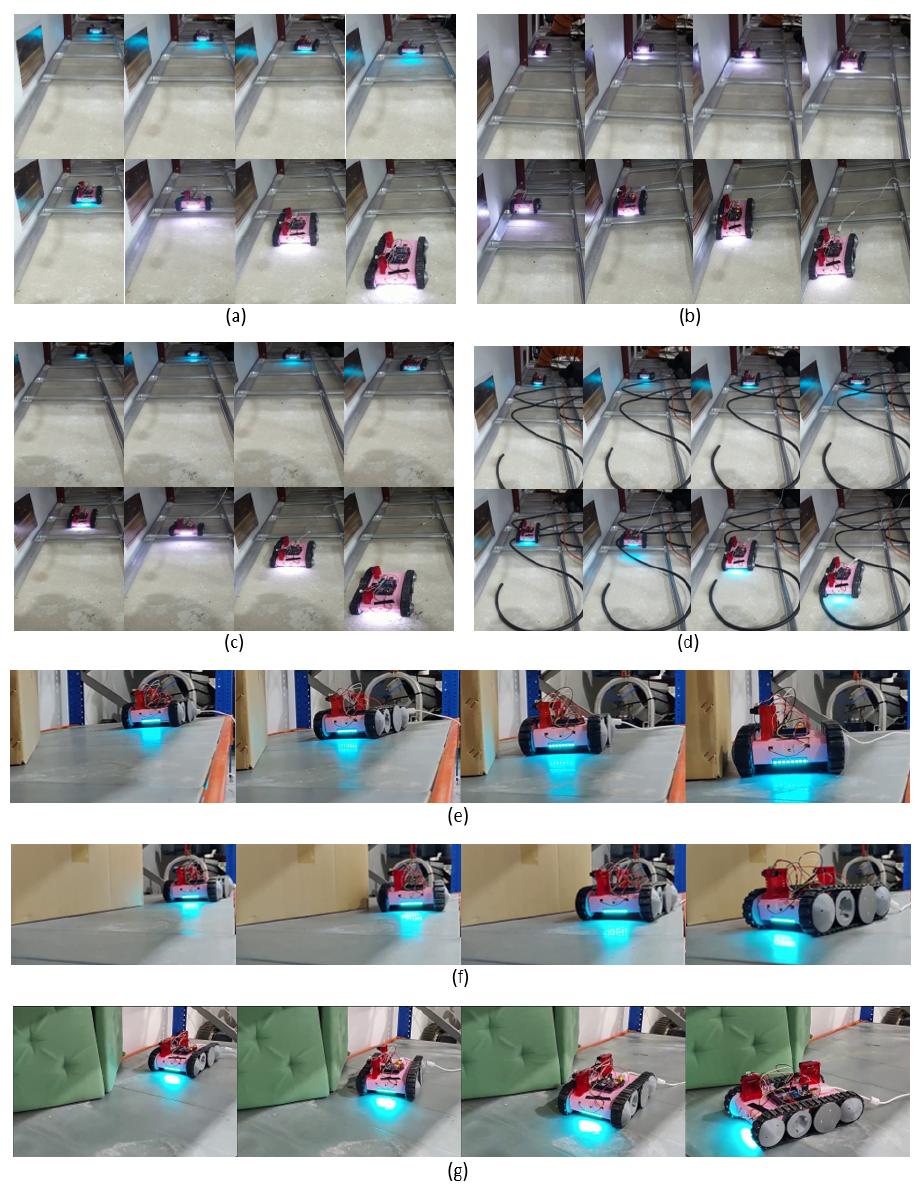
Figure 11. Snapshot sequences of the robot’s movements during the test cases explained in Figure 9. The snapshots displayed here for a test case are evenly distributed within the duration of the case. ( a ) The robot was placed with no heading error with the perimeter wall. ( b ) The robot was placed with an inward heading error. ( c ) The robot was placed with an outward heading error. ( d ) A segment with more objects to be traverse. ( e ) A segment with an inward slanting perimeter. ( f ) A segment with an outward slanting perimeter. ( g ) A segment with an inward and outward slanted